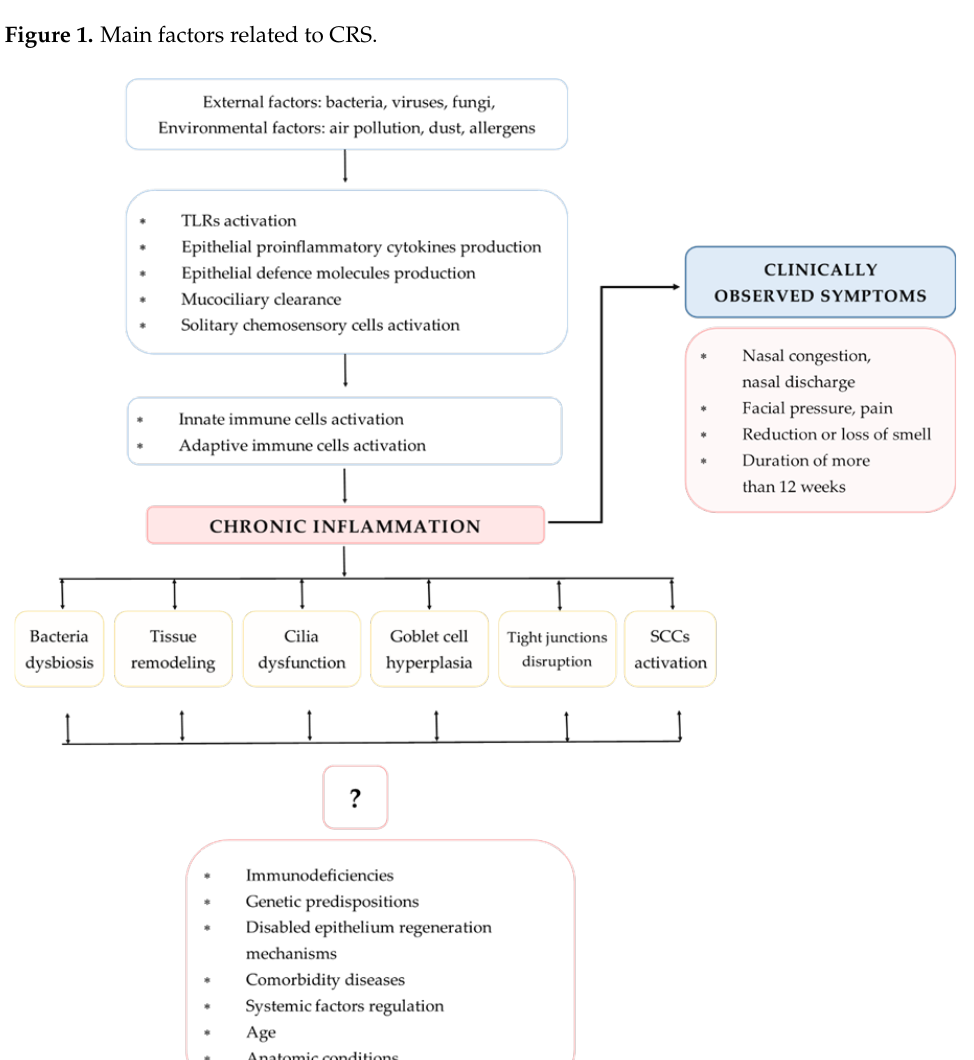
Figure 2. Mechanisms involved in CRS pathogenesis (TLRs — Toll-like receptors; SCCs — solitary chemosensory